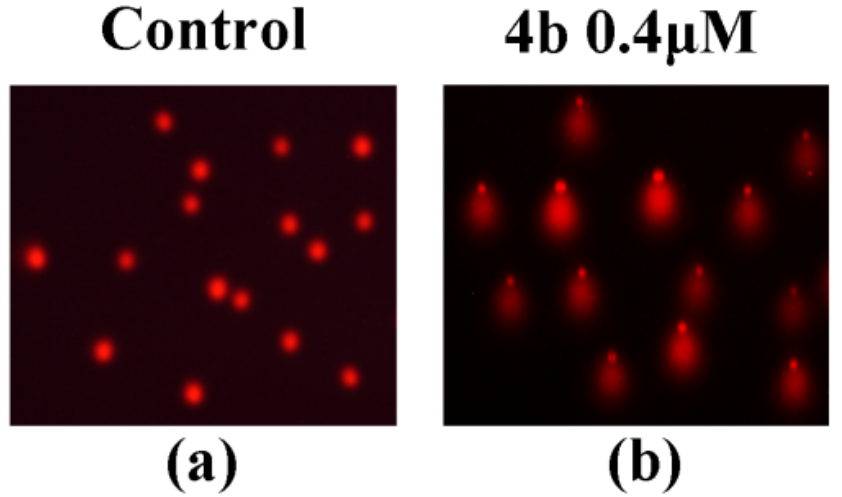
Figure 6. Comet assay of EB-stained MCF-7 cells in the control ( a ) and treated by 0.4 µ M of the complex 4b ( b ) after 24 h incubation.